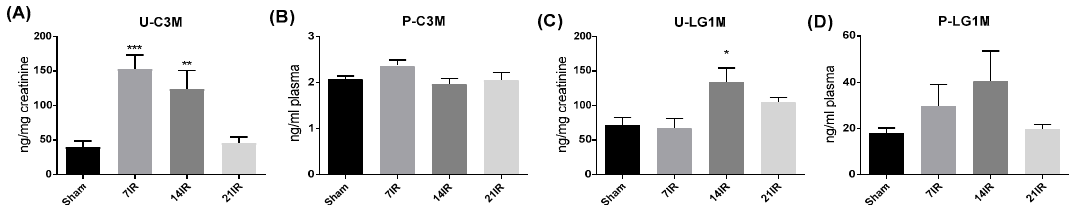
Figure 3. Noninvasive extracellular matrix (ECM) markers; type III collagen (C3M); and alpha-5, beta-2, and gamma-1 chain (LAMC1) in urine and plasma: ( A ) urine C3M (U-C3M), ( B ) plasma C3M (P-C3M), ( C ) urine LG1M (U-LG1M), and ( D ) plasma LG1M (P-LG1M). ANOVA with Bonferroni multiple comparison test was performed between sham and IRI. Each bar represents the mean ± SEM,